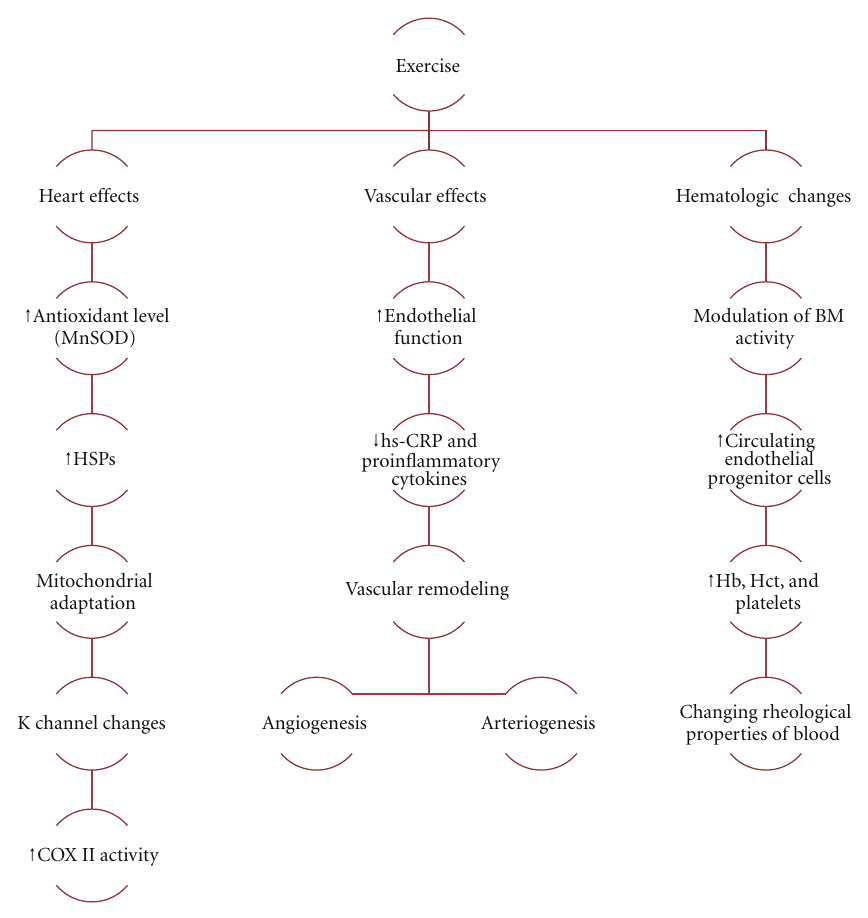
Figure 1: Selected e ff ects of excise on heart, vessels and blood components of cardiovascular